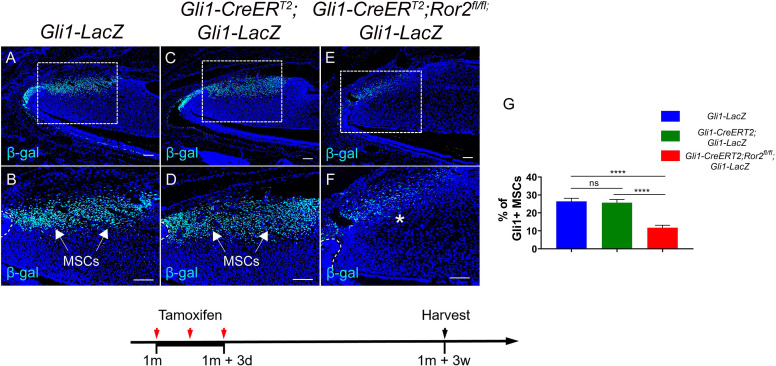
(A-F) Immunostaining of β-gal in Gli1-LacZ, Gli1-CreERT2;Gli1-LacZ and Gli1-CreERT2;Ror2fl/fl;Gli1LacZ incisors 3 weeks after tamoxifen induction.(G) Quantitative analysis of Gli1+ MSCs in the mesenchyme of Gli1-LacZ, Gli1-CreERT2;Gli1-LacZ and Gli1-CreERT2;Ror2fl/fl;Gli1-LacZ incisors at higher magnification (B, D and F) 3 weeks after tamoxifen induction.